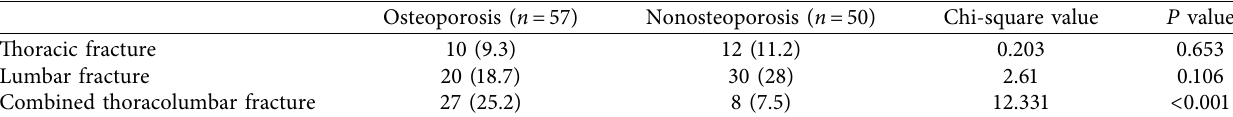
Figure 2: (a) Te box plot showed the correlation between PMI and fracture status in all subjects. (b) ∼ (d) Te three box plots showed the correlation between PMI and fracture status after grouping by T -score. Te top-to-bottom data next to each box plot were the maximum, upper quartile, median, lower quartile, and minimum values of PMI. “ n ” indicates the number of cases in each group. Table 2: Te relationship between vertebral fracture site and